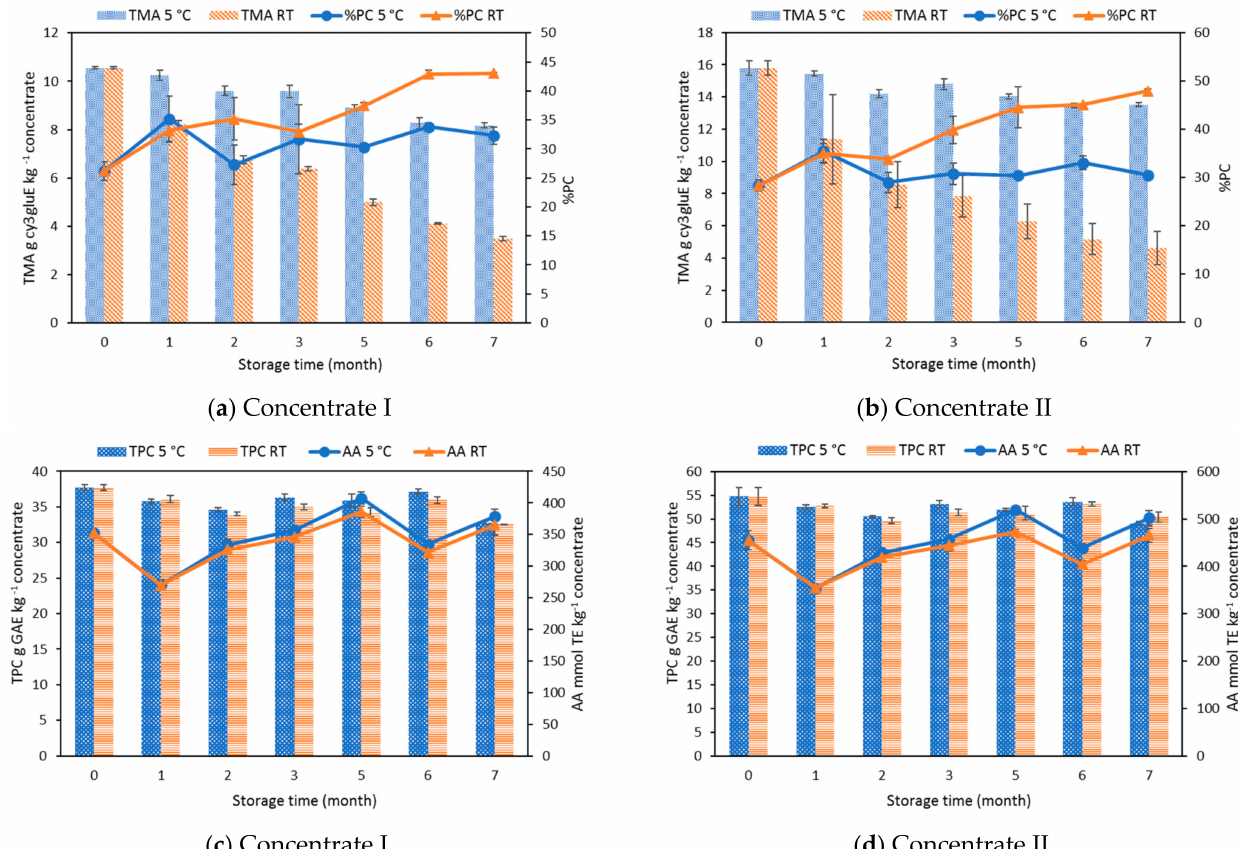
Figure 3. Evolution during storage at 5 ◦ C and at room temperature (RT) for total monomeric anthocyanins (TMA) and percent polymeric color (%PC) in ( a ) concentrate I, ( b ) concentrate II; and total phenolic content (TPC) and antioxidant activity (AA) in ( c ) concentrate I and ( d ) concentrate